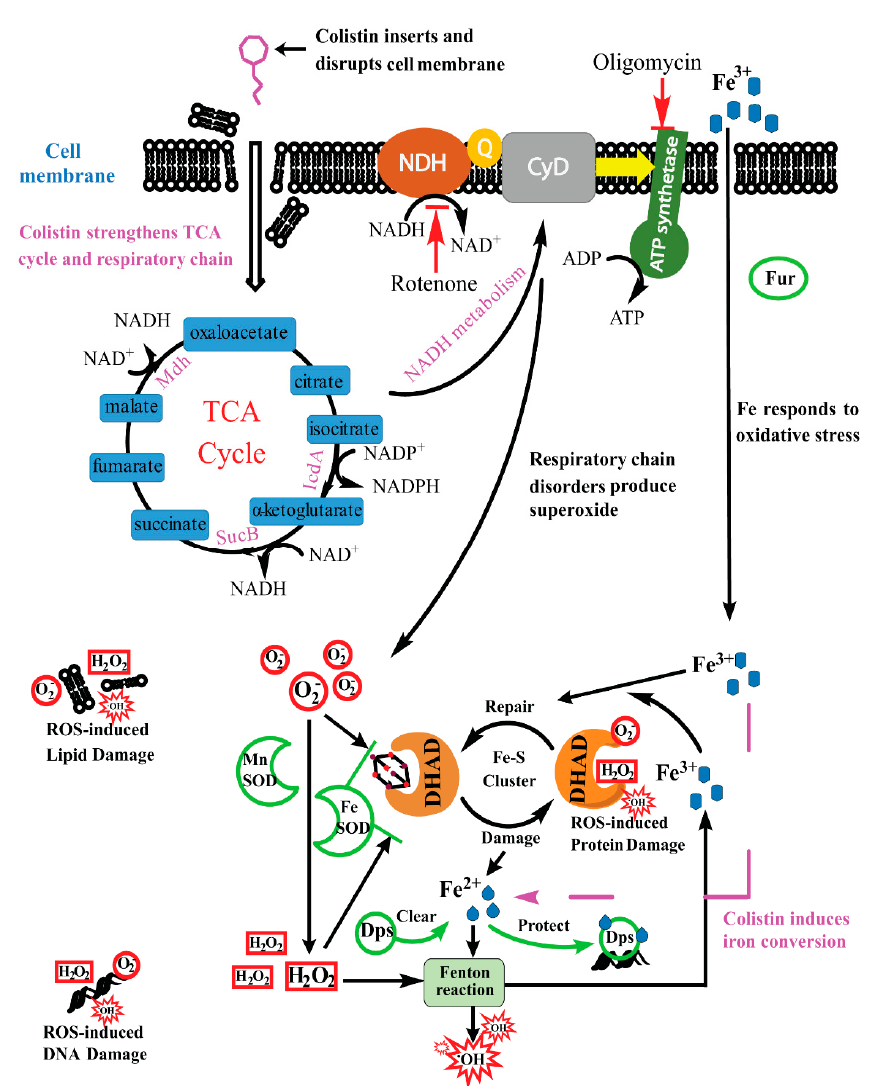
Figure 7. Proposed lethality of colistin against Gram-positive bacteria due to binary actions of cell permeability and oxidative stress [11,24,34]. DHAD: dihydroxy-acid dehydratase; Fur: ferric uptake regulator; Dps: DNA-binding protein from starved cells for sequestering Fe 2+ ; NDH: NADH dehydrogenase; CyD: cytochrome d -type ubiquitone oxidases; SOD: superoxide dismutases; Fenton reaction: oxidization of Fe 2+ by H 2 O 2 to Fe 3+ along with hydroxyl radicals ( • OH) formation; O 2 − : superoxide; TCA cycle: tricarboxylic acid cycle; ROS: reactive oxygen species.